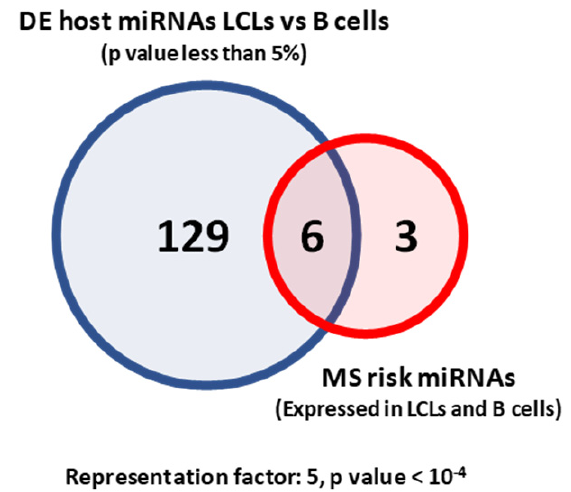
Figure 3. The over-representation of MS risk miRNAs differentially expressed (DE) between LCLs and B cells. We identified differentially expressed miRNAs in LCLs and B cells with a p value less than 0.05. MS risk miRNAs over-representation in DE miRNAs between LCLs and B cells.